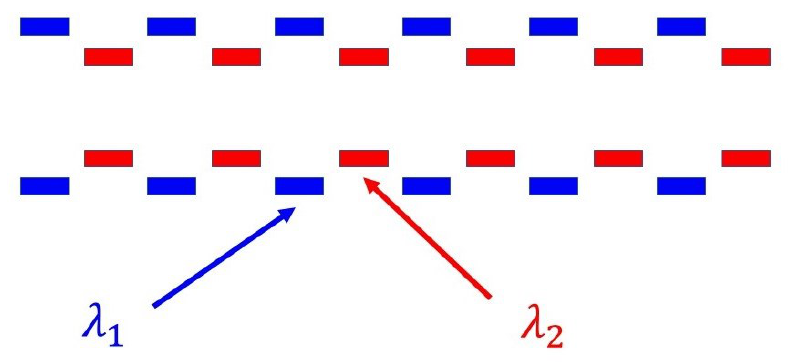
Figure 1. Conceptual scheme of two-color lasing with the alternation of undulator tunes. The figure was published in [17].